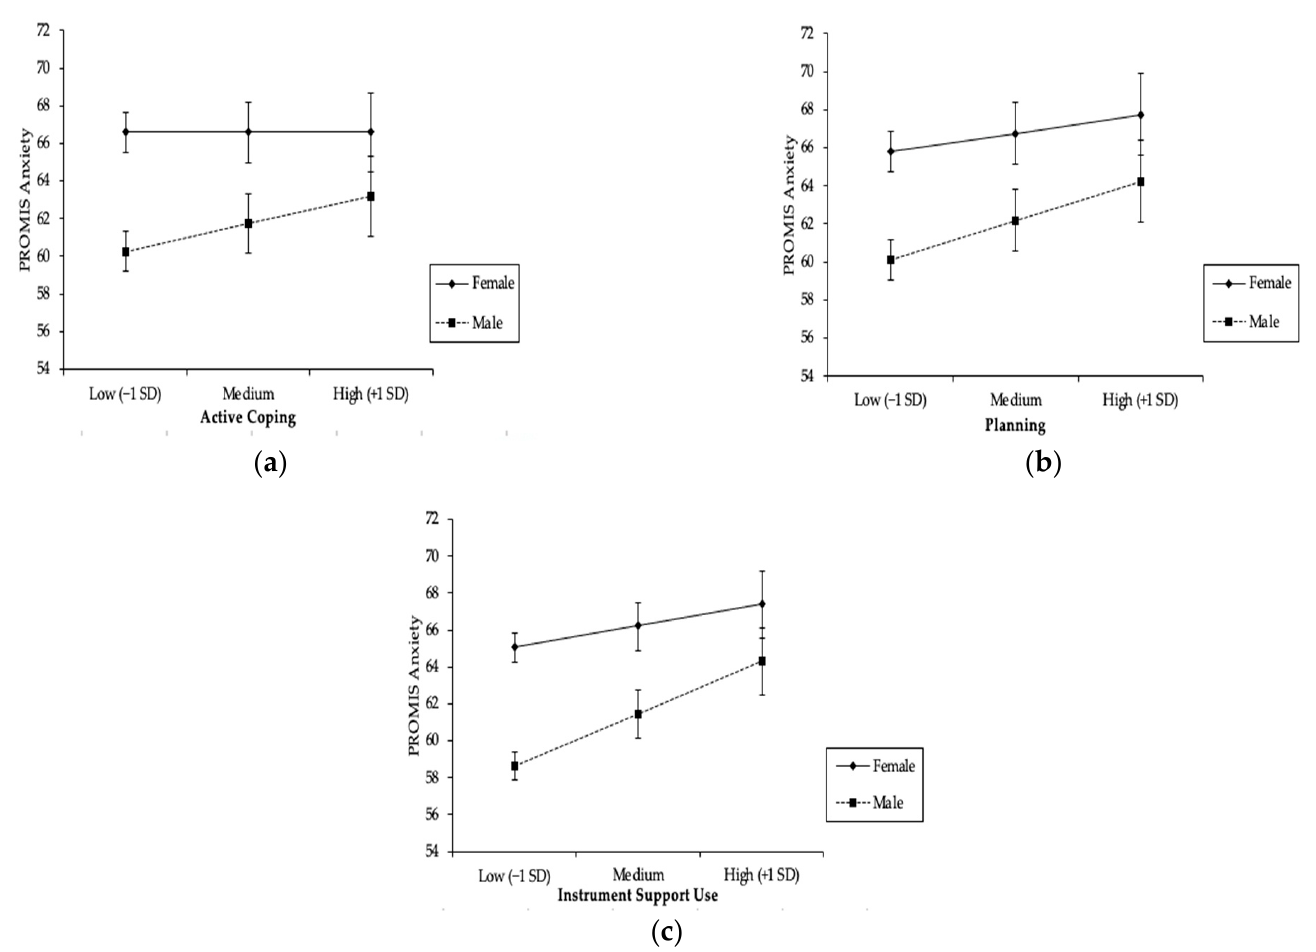
Figure 1. Results of Linear Regression Analysis Showing PROMIS Anxiety Scores as a Function of Problem-focused Coping Strategies and Gender: ( a ) moderation by gender on the effect of active coping on PROMIS Anxiety; ( b ) moderation by gender on the effect of planning on PROMIS Anxiety; ( c ) moderation by gender on the effect of instrument support use on PROMIS Anxiety.